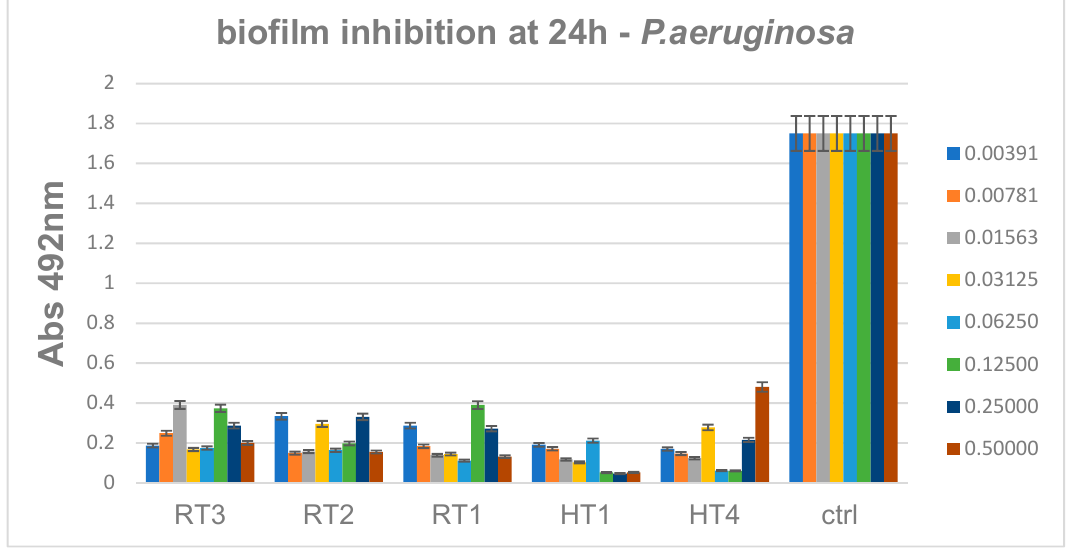
Figure 16. Inhibition of P. aeruginosa biofilm development in the presence of the obtained AgNPs for 24 h, p < 0.001 when comparing Abs 492 nm values of RT and HT samples control .